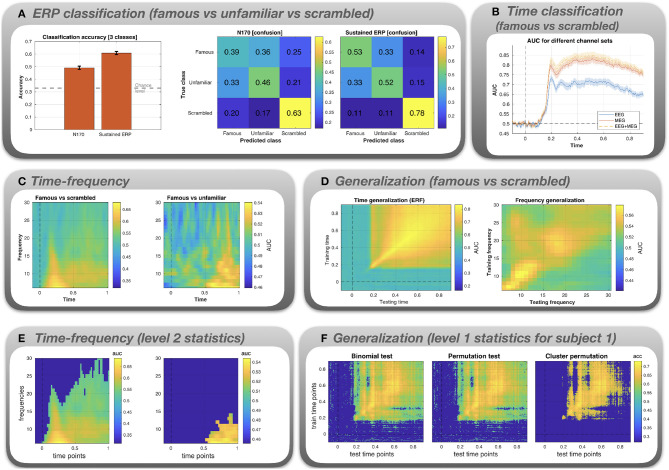
Results for the classification analysis of the Wakeman and Henson (2015) MEEG data. (A) Multi-class classification (famous vs. unfamiliar vs. scrambled faces) of N170 and sustained ERP component. (B) AUC is plotted as a function of time for famous vs. scrambled images. The classification was performed using three different channel sets: EEG only, MEG only, and EEG+MEG combined. (C) Binary classification (famous vs. scrambled and famous vs unfamiliar) for time-frequency data. AUC is plotted as a function of both time and frequency. The AUC values are color-coded. (D) Time x time generalization and frequency x frequency generalization using a binary classifier (famous vs. scrambled). (E) Level 2 statistical analysis of the time-frequency classification. (F) Level 1 statistical analysis of the time x time generalization, shown exemplarily for subject 1.